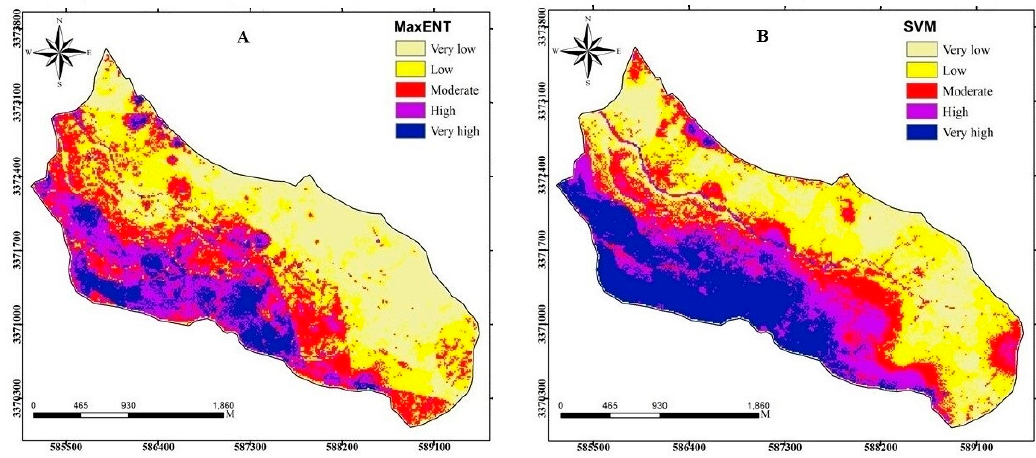
Figure 3. Habitat suitability maps using: ( A ) maximum Entropy (MaxEnt), and ( B ) support vector machines (SVM) models.